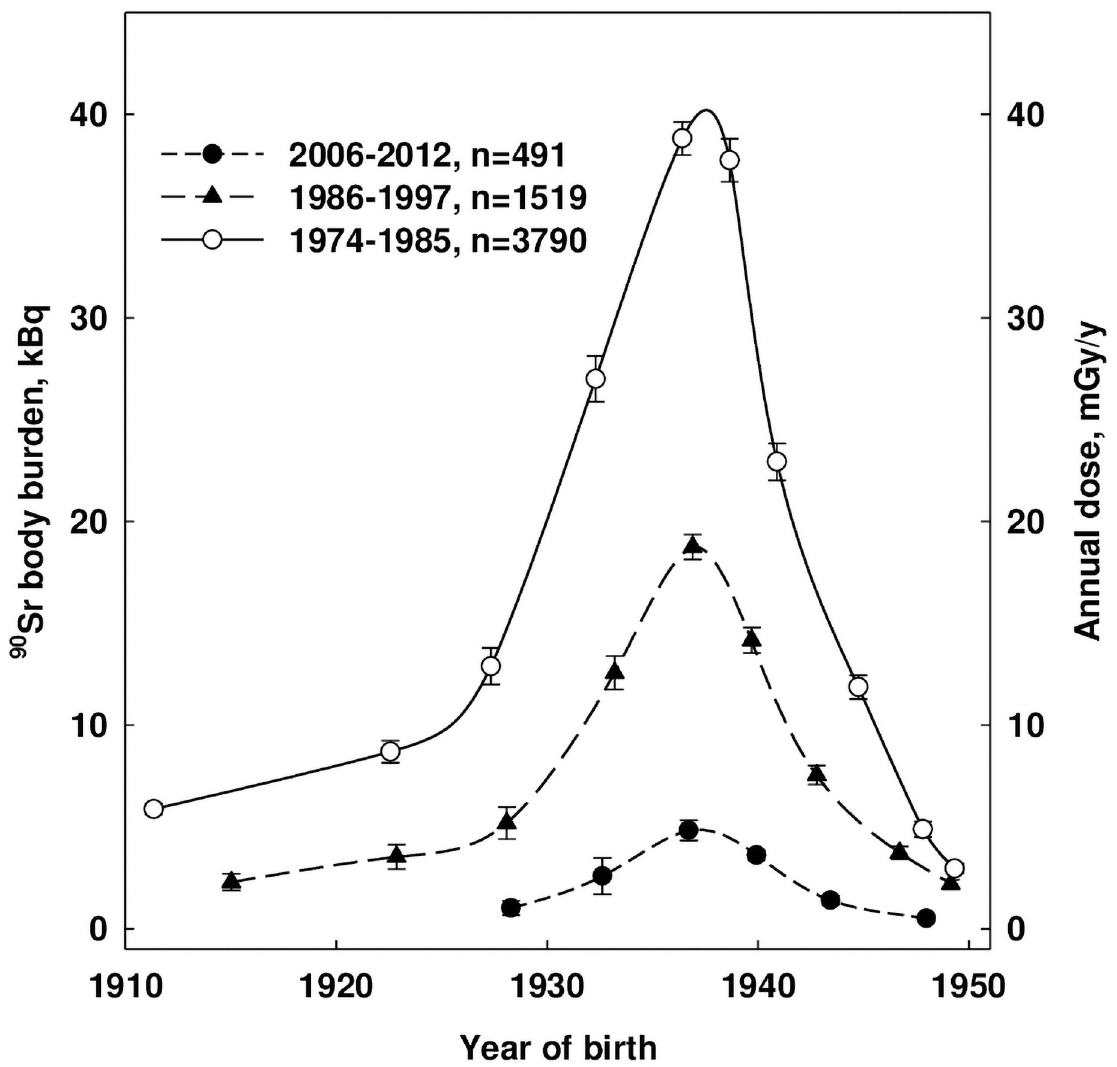
Fig 6. Estimation of dose rate in femoral AM for different age cohorts of the Techa River residents with 90 Sr-body burden measured during 3 different time periods (vertical bars represent error of